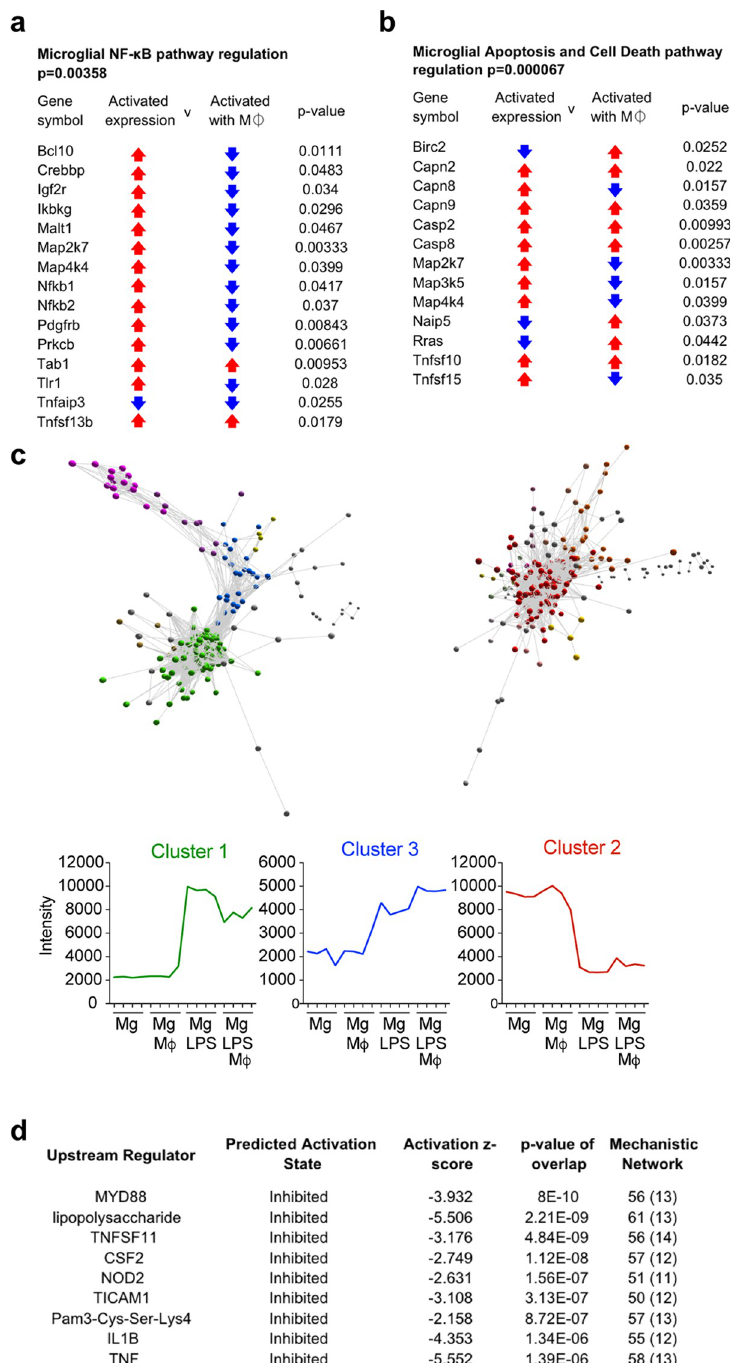
Fig 2. Transcriptional profiling reveals macrophages suppress key inflammatory pathways and dysregulate apoptotic cell death pathways in adult mouse microglia. Transcriptional profiling of mouse microglia revealed 1,076 differentially expressed genes between LPS-treated microglia in the presence or absence of macrophages. ( a, b ) IPA of the top dysregulated pathways within differentially expressed transcripts. NF- κ B ( a ) and apoptosis and cell death ( b ) were the most significantly dysregulated in terms of number of genes and significance. Arrows in the “Activated expression” column indicate individual gene regulation when the pathway is induced in LPS-stimulated microglia (red = up-regulated, blue = down-regulated). Arrows in “Activated with M ϕ ” column indicate individual gene regulation of LPS-stimulated microglia in the presence of macrophages. ( c ) A transcript-to-transcript correlation network plot of transcripts significantly changed in LPS-stimulated microglia in the presence of macrophages;